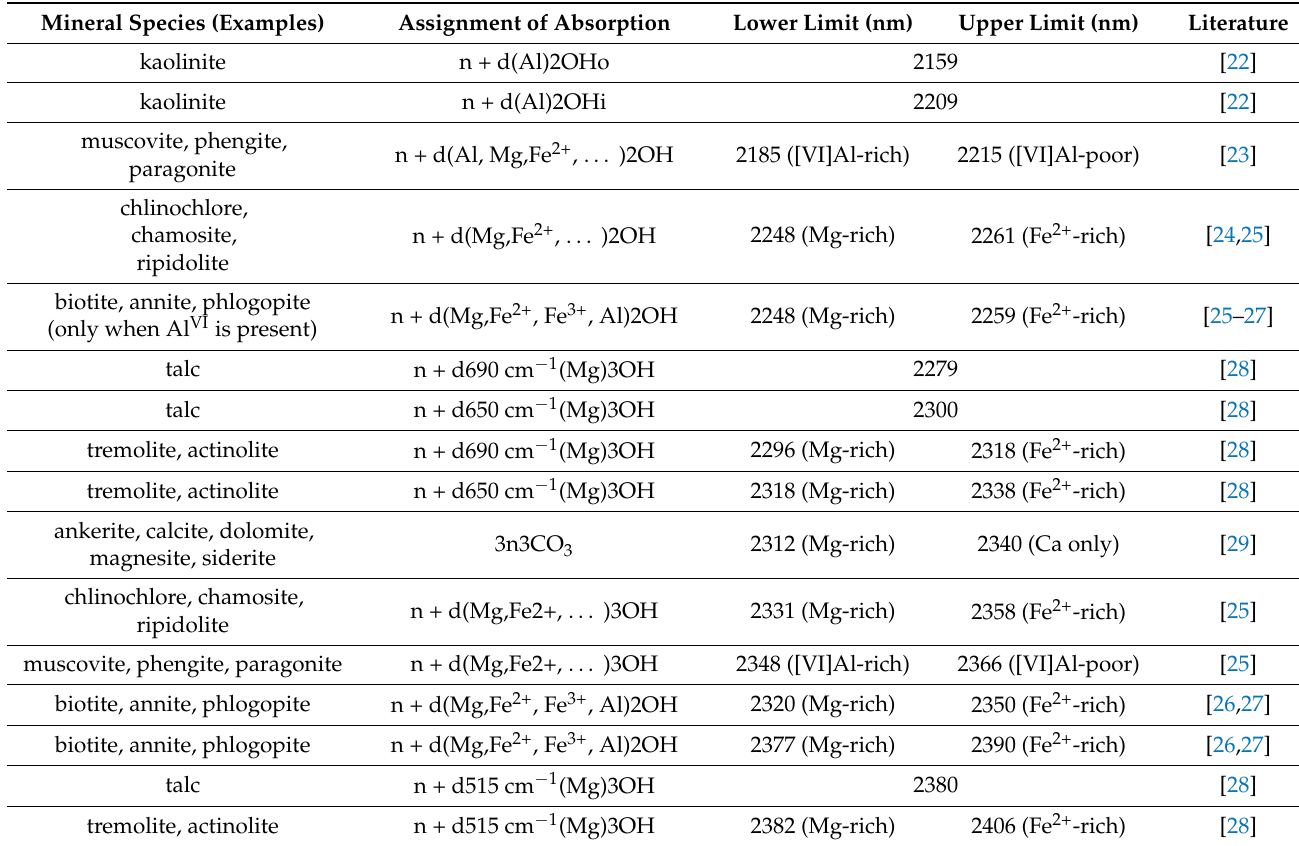
Table 1. A summary of the major absorption features of minerals present at the case study area. It is noted that respective absorption bands can be present in minerals that are not listed in the table. However, only minerals that are present in the study area are shown. The lower and upper wavelength positions are only given for absorption bands where related compositional changes are discussed in this study. Otherwise, an estimated central location is provided. White mica includes illite and sericite and n 3CO 3 —asymmetric stretch of CO 3